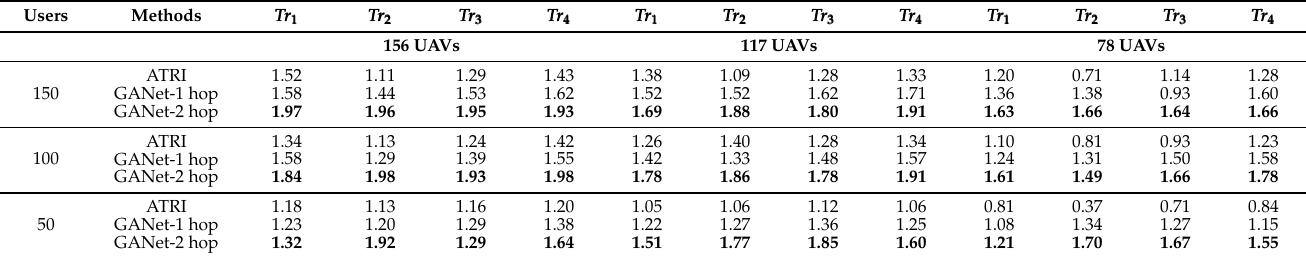
Table 4. Comparing fitness with different numbers of UAVs and users on training